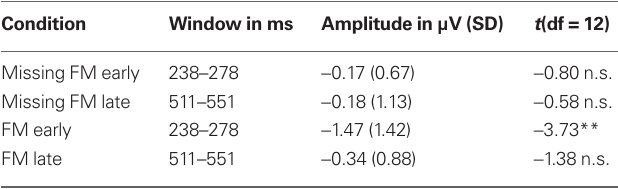
Table 1 | Mean MMN amplitudes measured at Fz for the conditions Missing FM early, Missing FM late, FM early, and FM late